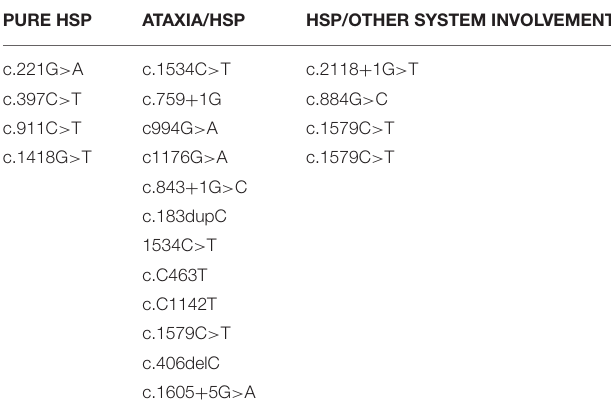
TABLE 1 | List of the variants described so far. Mutations spread along the entire gene irrespectively of the